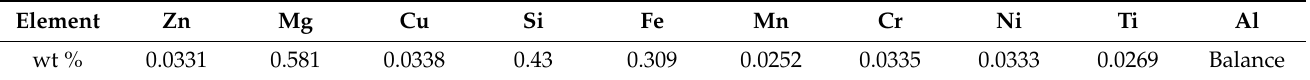
Table 1. Chemical composition of recycled AA 6063 (wt